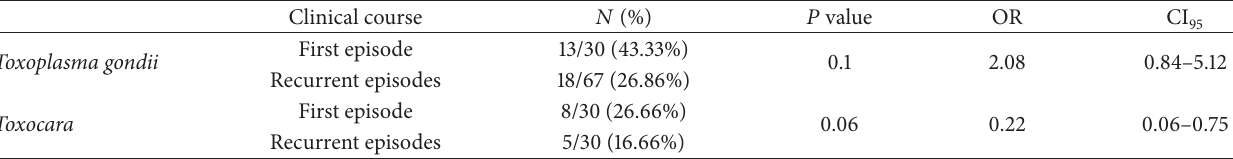
Table 4: The distribution of Toxoplasma gondii and Toxocara antibodies in patients with schizophrenia based on clinical course of treatment.